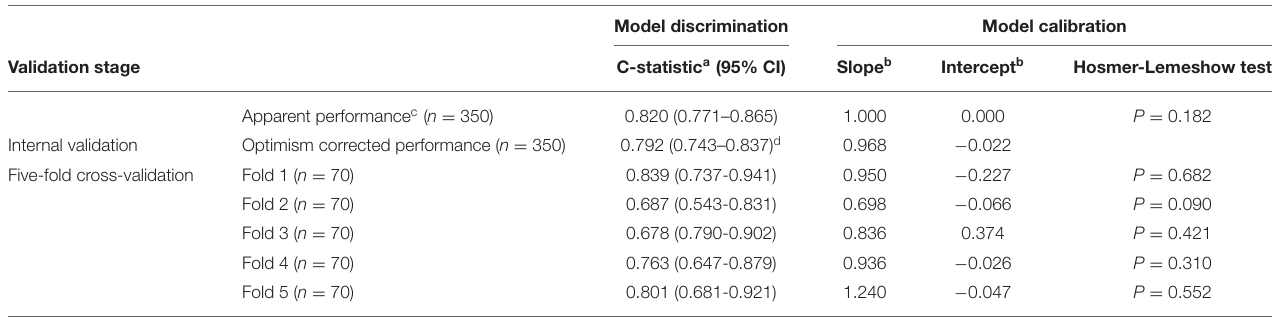
TABLE 3 | Model performance parameters in the total cohort and after 5-fold